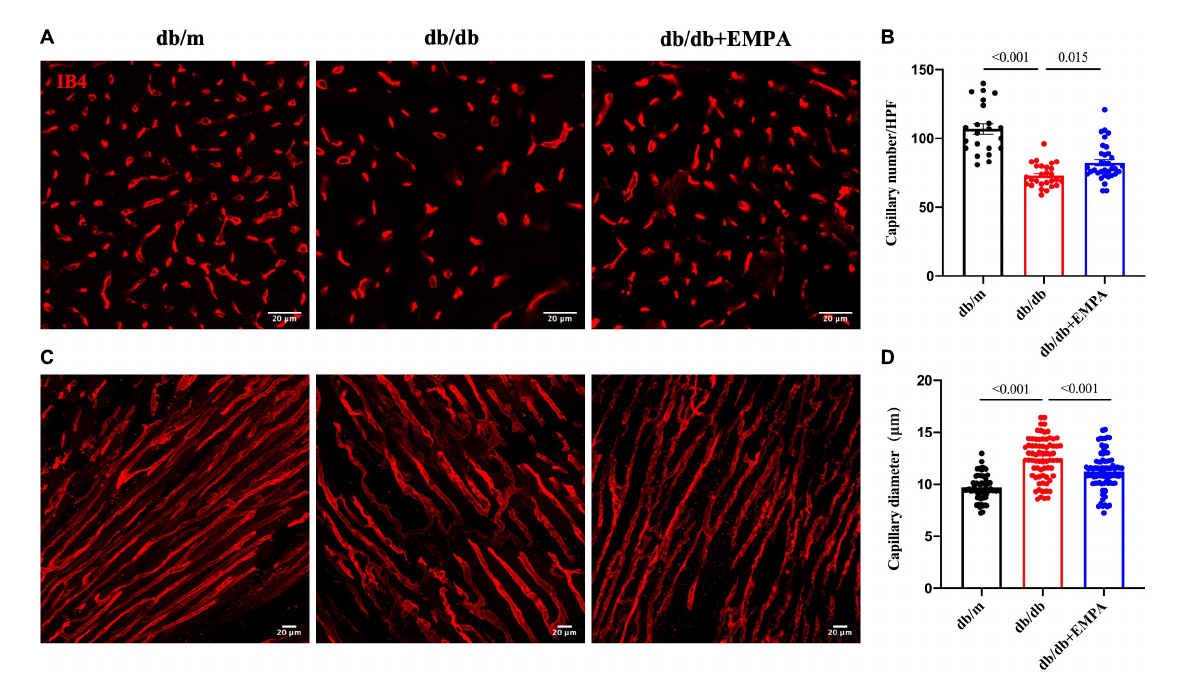
FIGURE4 Effects of empagliflozin treatment on the cardiac microvasculature of db/db mice. (A) Representative transverse images of myocardial vasculature showing capillaries (IB4+, red). (B) Statistical analysis of the density of capillaries in the transverse sections of myocardial tissue between the db/m group, db/db group, and db/db + EMPA group. (C) Representative longitudinal images of myocardial vasculature showing capillaries (IB4+, red). (D) Statistical analysis of the diameter of capillaries in the longitudinal sections of myocardial tissue between the db/m group, db/db group, and db/db + EMPA group. Data are presented as the means ± SEM. P -values are corrected for multiple comparisons. IB4, isolectin B4; HPF, high power